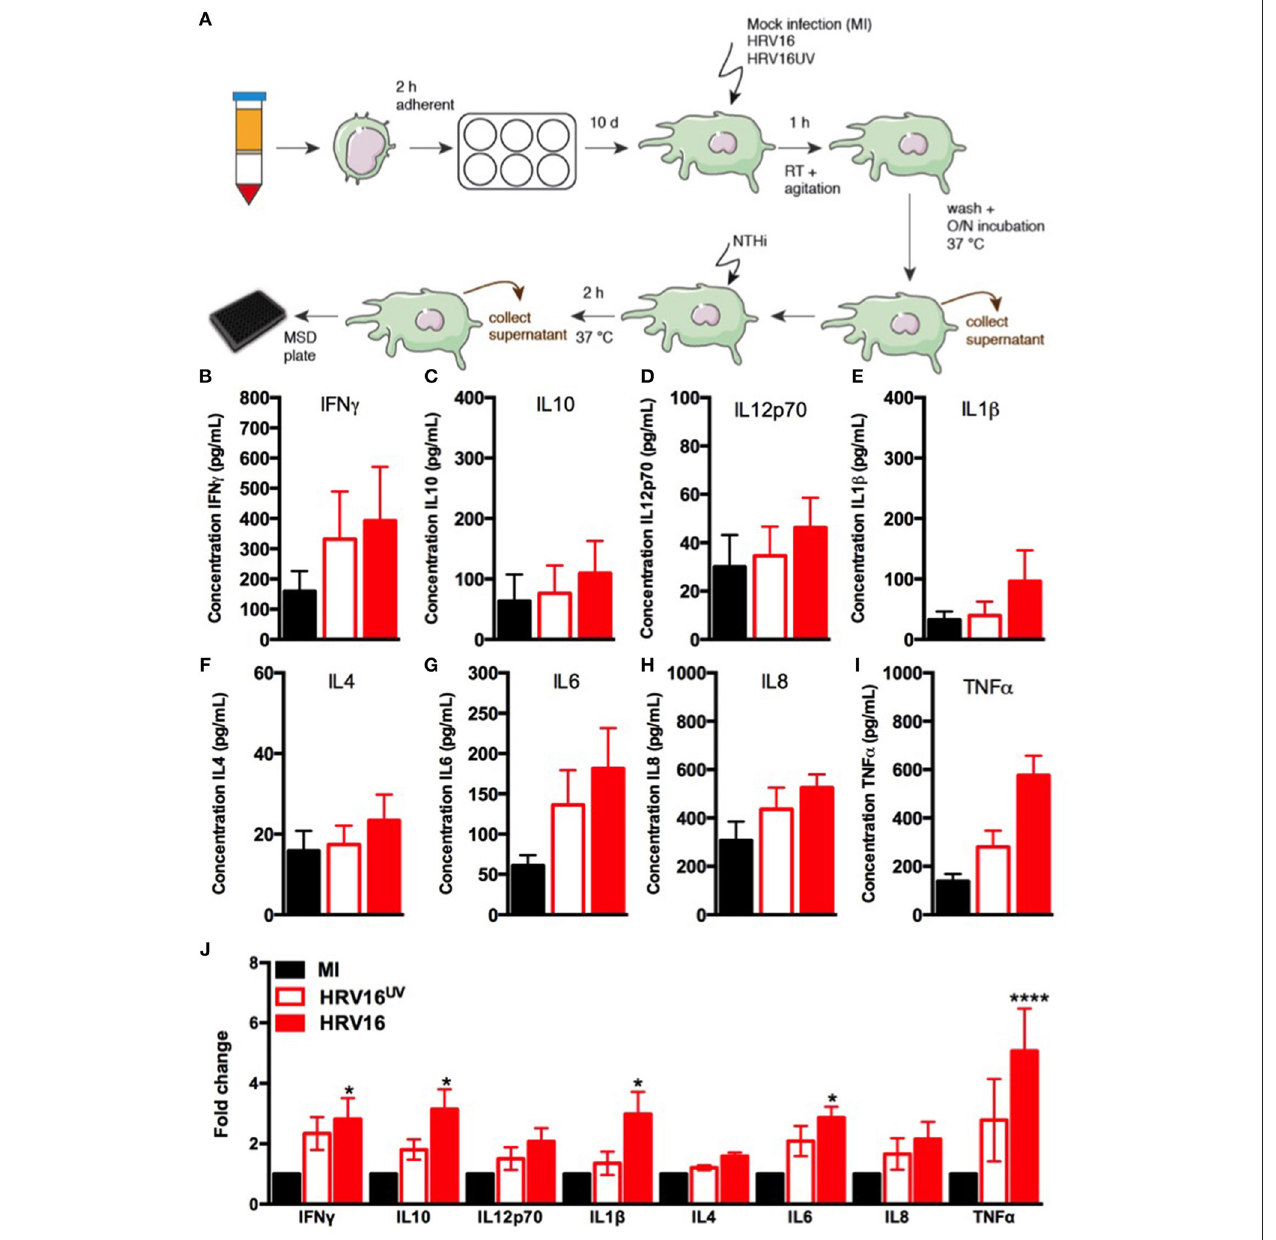
FIGURE 1 | Human macrophages release pro-inflammatory and regulatory cytokines in response to HRV16. (A) Experimental protocol: human macrophages differentiated from blood monocytes were exposed to HRV16 (red bars), HRV16 UV (open bars) or MI (black bars) for 1h and rested overnight. Supernatants were collected and analyzed by MSD. MSD results for (B) IFN γ , (C) IL10, (D) IL12p70, (E) IL1 β , (F) IL4, (G) IL6, (H) IL8, (I) TNF α , (J) Relative fold changes for cytokine production in HRV16 and HRV16 UV exposed human macrophages vs. MI. n = 5 independent experiments on different donors. Error bars represent standard error of the mean (SEM). * p < 0.05, **** p < 0.0001 Two Way Anova with Dunnett’s Post Test vs.